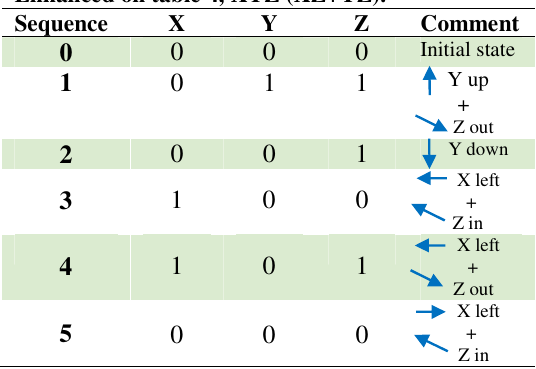
Enhanced on table 4, XYZ (XZ+YZ).